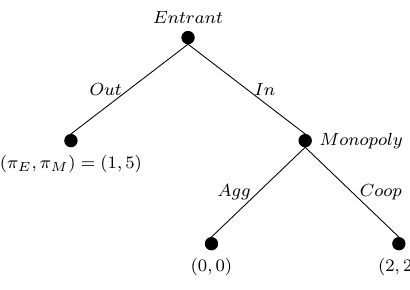
Figure 1. The One-Stage Chain Store Game.